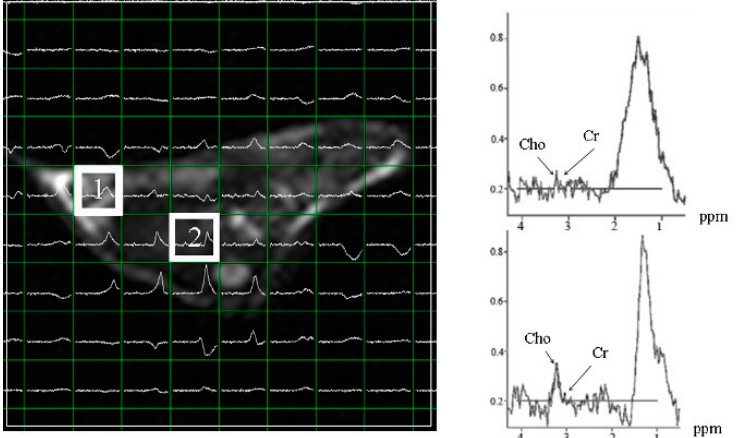
Figure 5. Multi-voxel spectra of hepatoma in subcutaneous Hep-G2-xenografted mice after 25 days of inoculation. Voxel 1 shows the inoculation point of Hep-G2. Voxel 2 shows the maximum choline levels, indicating that Hep-G2 cells migrated from voxel 1 to voxel 2. Cho: choline; Cr: creatine.